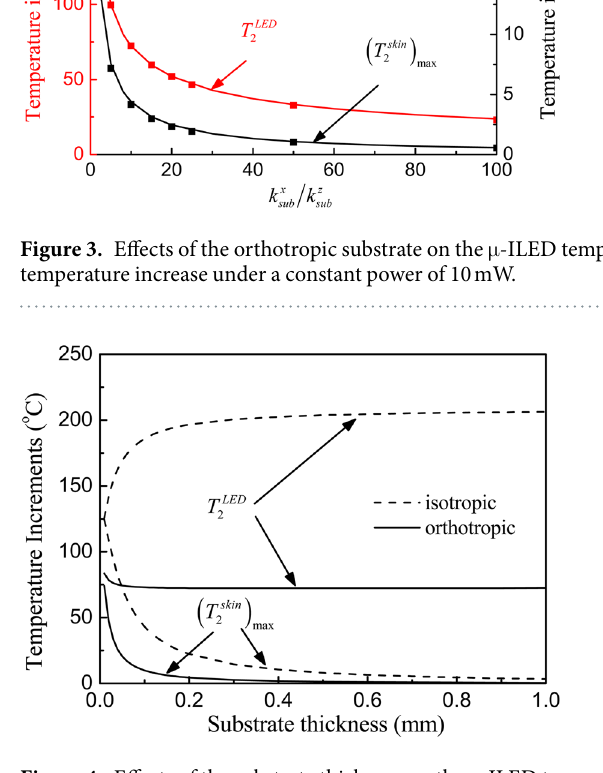
Figure 4. Effects of the substrate thickness on the μ -ILED temperature increase and the maximum skin temperature increase under a constant power of 10